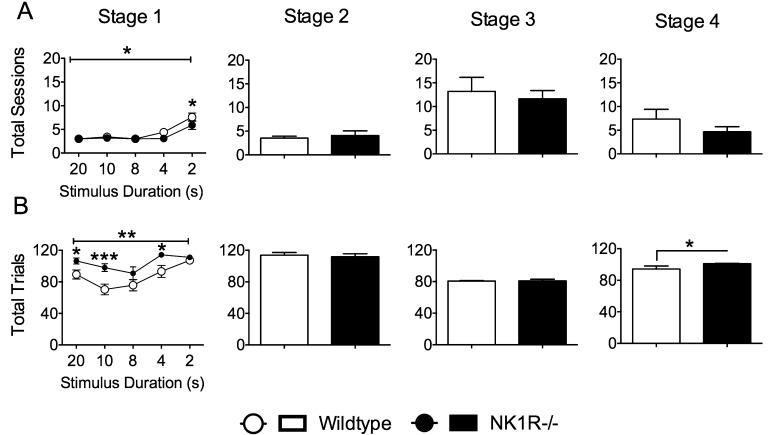
During training in the 5C-CPT, NK1R−/− mice needed fewer daily sessions to reach performance criteria and they completed more trials than their wildtypes. Circles/bars show mean ± s.e.m. For Stages 2–4, the bars show data for the first day of training, only. A: total sessions required to attain performance criterion at each stage of training; and B: total trials completed. Numbers on abscissae for Stage 1 specify the stimulus durations (SD: gradually reduced from 20 to 2 s as animals achieved progression criteria). A line above graphs/bar charts indicates an overall difference between NK1R−/− and wildtype mice. Statistical significance of differences between pairs of data (compared by genotype) indicated by: *P < 0.05; **P < 0.01; ***P < 0.001. N = 12 per group.